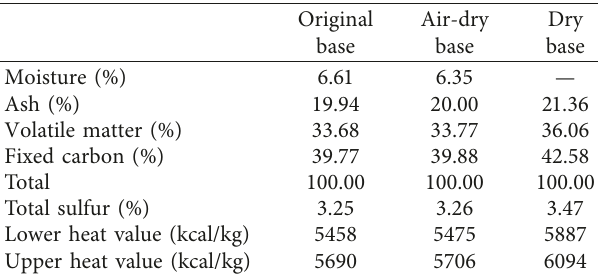
Table 3: Chemical analysis results of Sample-C1 coal [24].